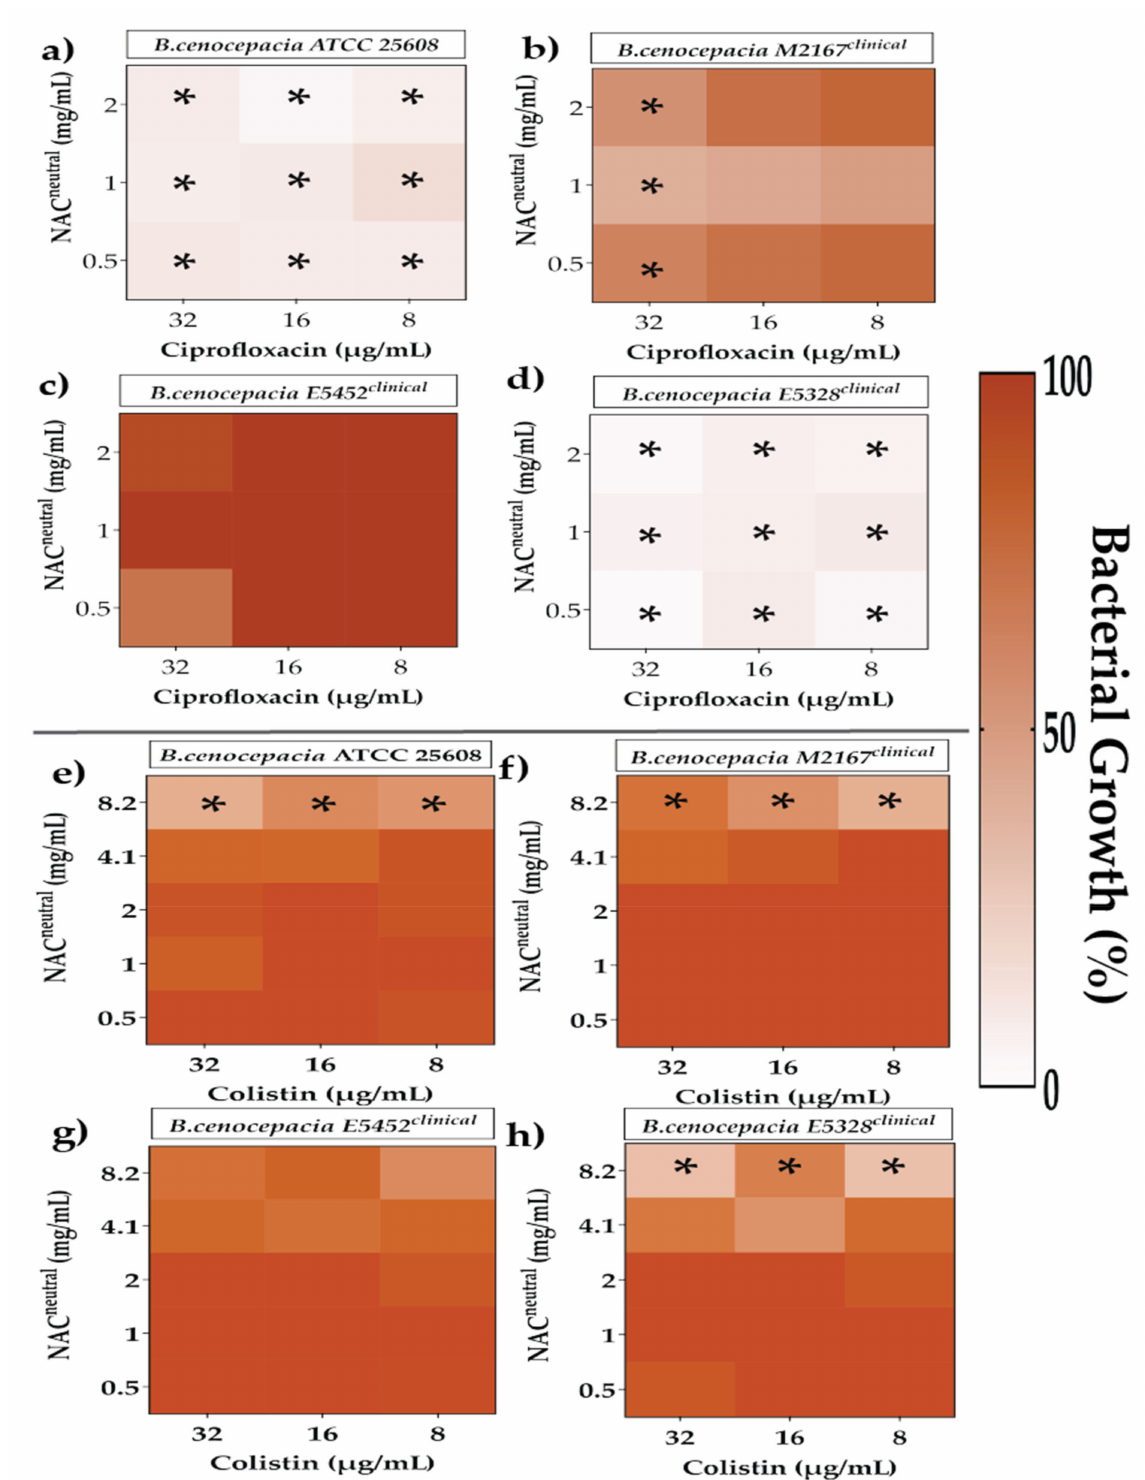
Figure 5. The effect of chosen synergistic and additive combinations against irreversibly attached Burkholderia cenocepacia. Heat map representing greyscale-coded planktonic bacterial growth where black represents 100% bacterial growth and white represents 0% irreversibly attached planktonic bacterial growth. Irreversibly attached bacterial growth has been measured in the presence of ciprofloxacin ( a – d ) and colistin ( e – h ) in combination with NAC neutral for B. cenocepacia strains. Statistical analyses were performed using one sample t -test and Wilcoxon rank tests. Significance cut-offs are as follows p ≤ 0.05 ( * ). Data represent an average of n = 3 biological